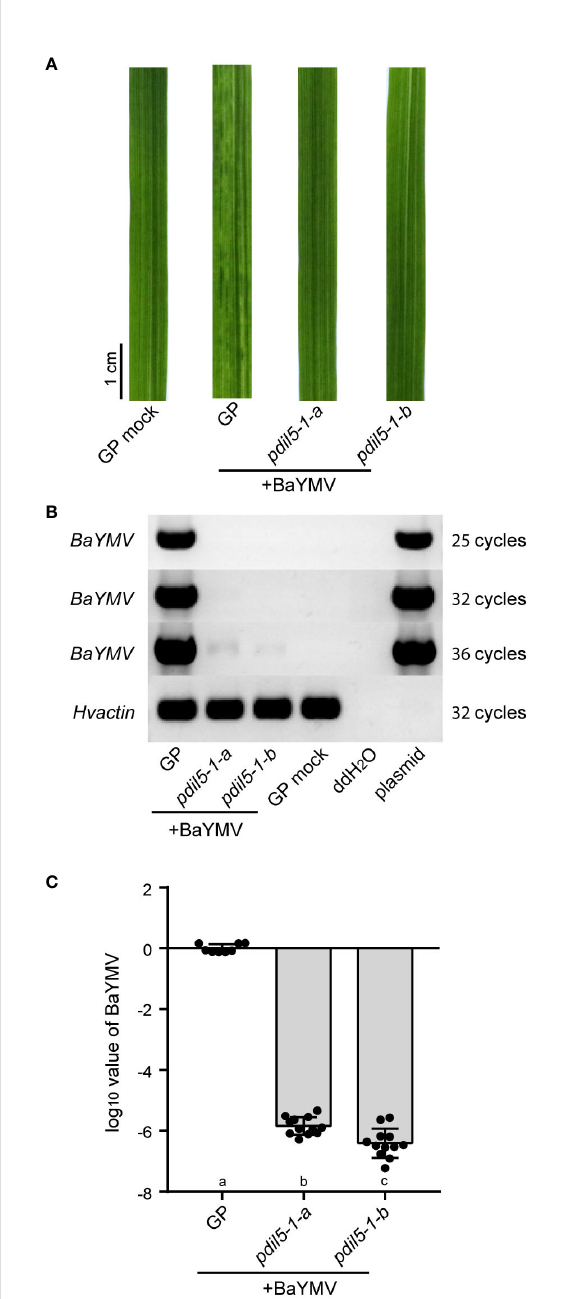
FIGURE 3 The pdil5-1 mutants confer BaYMV resistance. (A) Disease symptoms of the pdil5-1 mutants and wild type (GP, Golden Promise) at 6 weeks post BaYMV inoculation. RT-PCR (B) and qRT- PCR (C) detection of BaYMV accumulation. The barley actin gene was used at the endogenous control. In (C) , black dots represent individual assays ( n = 8 for wild type; n = 12 for pdil5-1 mutants). Error bars = SD. Statistical tests were conducted using Duncan ’ s multiple range test analysis of variance (ANOVA) ( p = 0.05); different letters below bars indicate statistically signi fi cant